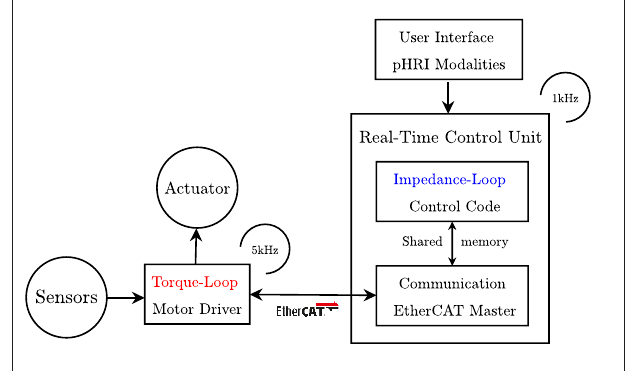
FIGURE 4 | Control framework block diagram. The inner torque loop is implemented in the motor driver. The outer impedance loop is implemented in the real-time control unit. Configuration files are used to personalize the controller parameters. The user can select the rehabilitation mode through a simple user